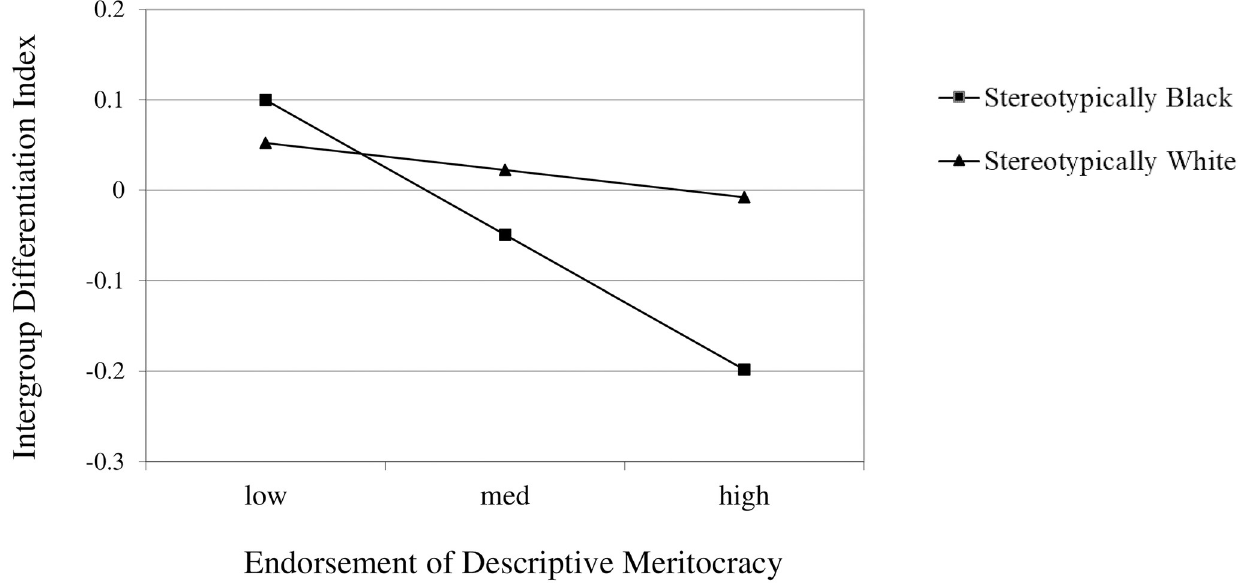
Fig 2. Stereotypes and Meritocracy interplay. Difference in the agreement with early release from prison between the Black and the White prisoners as a function of the interaction between the type of crime and levels of endorsement of descriptive Meritocracy.